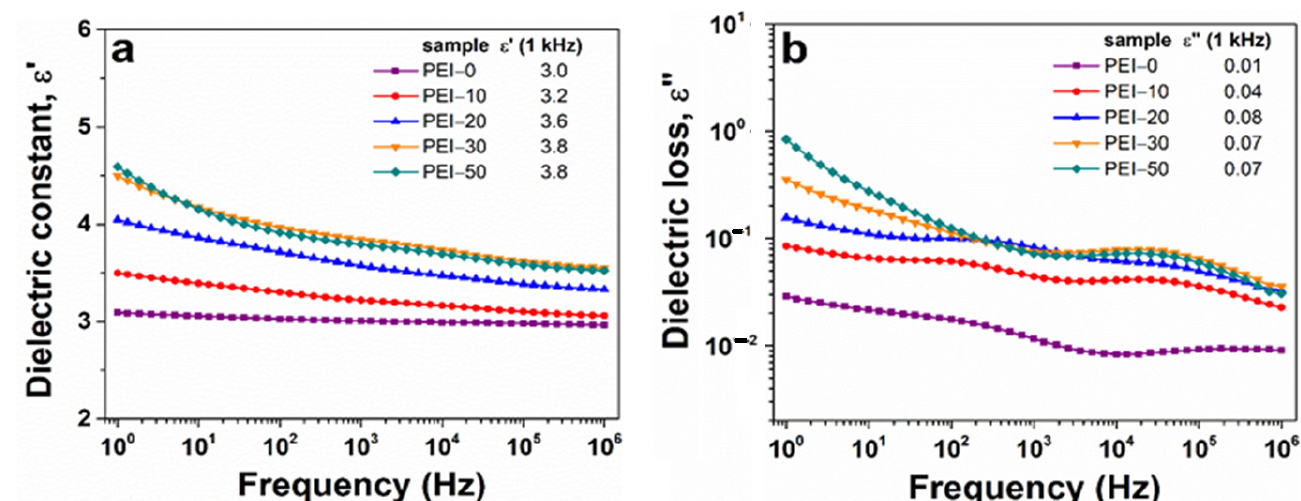
Figure 4. Frequency dependences of ( a ) dielectric constant and ( b ) dielectric loss at room temperature for the neat PEI-0 and the nanocomposites PEI-10, PEI-20, PEI-30, and PEI-50. The inset shows the numerical values of the ε′ and ε″ selected at 1 kHz.